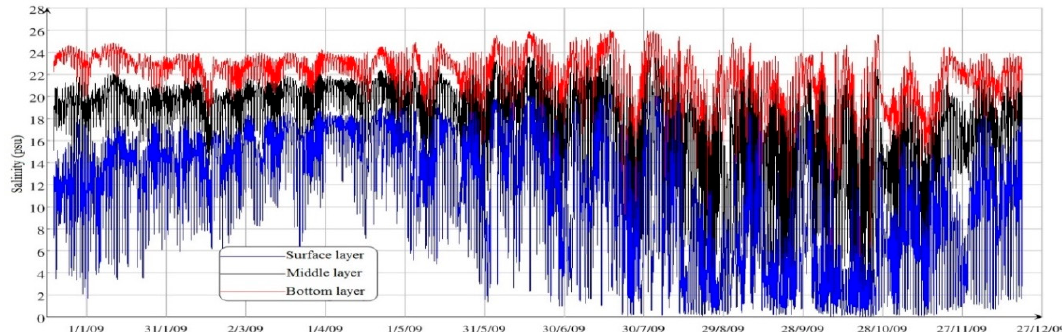
Figure 14. Time series of the distribution of salinity (psu) at station D2.